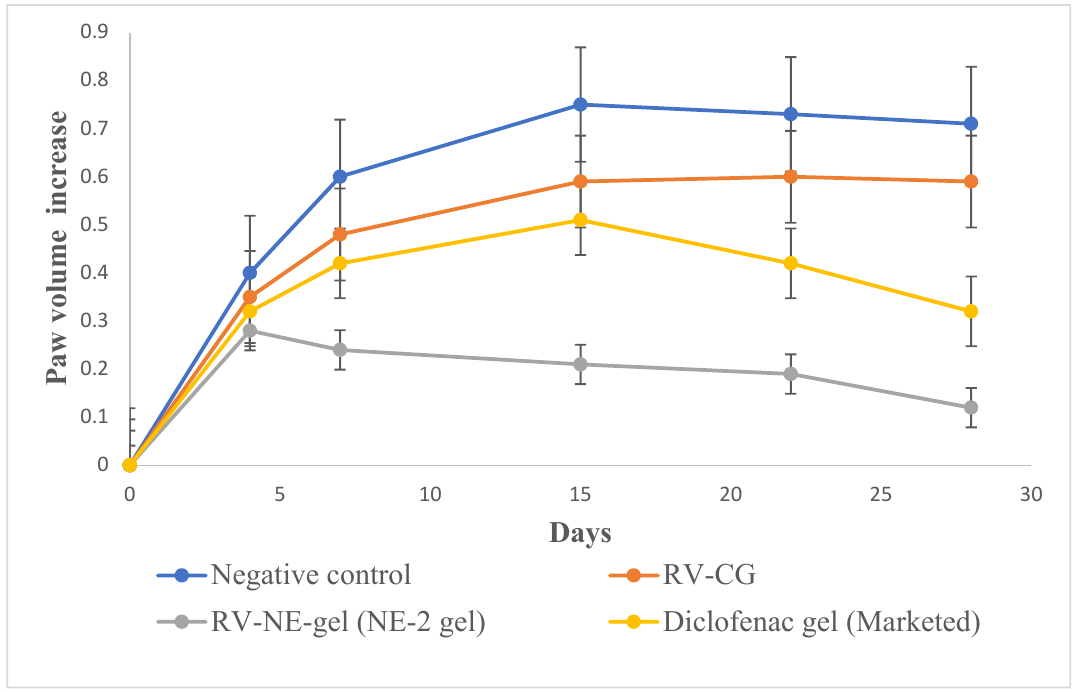
Figure 6. Change in in vivo parameters of different treatment groups on days specified for left hind paw volume increase. The average value ± SD ( n = 3) is represented by each cross bar. AC: arthritic control; NE: nanoemulsion; RV: resveratrol; CG: conventional gel. Table 5. Arthritic index (AI) and rate of arthritis inhibition (In) using the volume of the hind paws of each